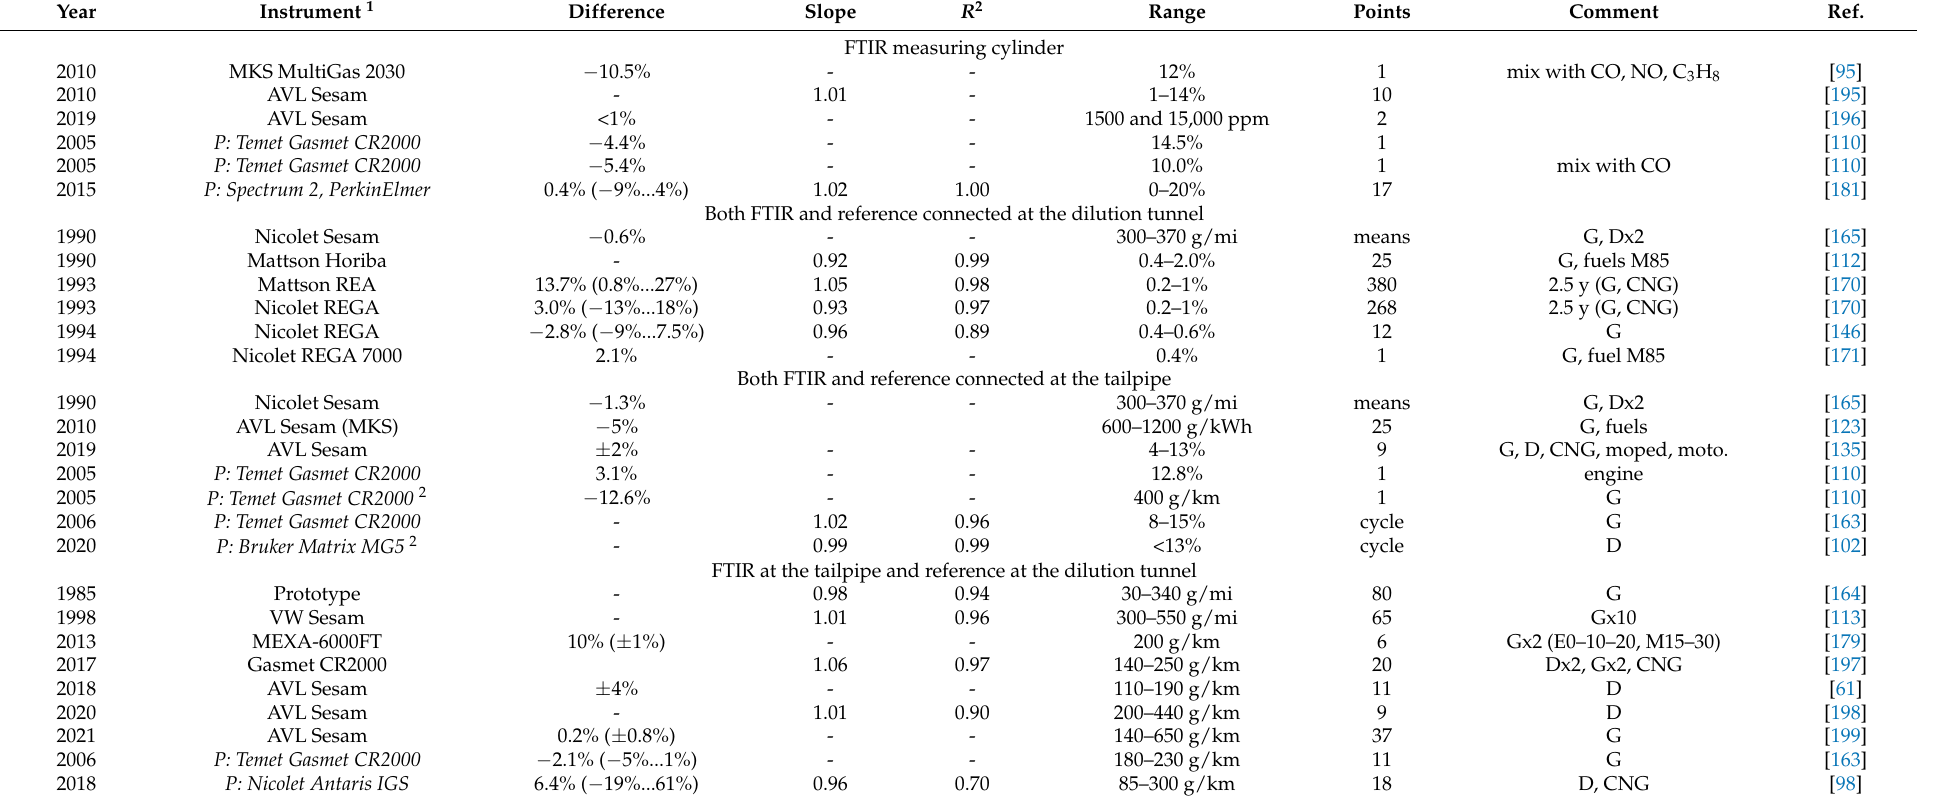
Table A1. Comparisons of FTIR with CO 2 analyzers (all